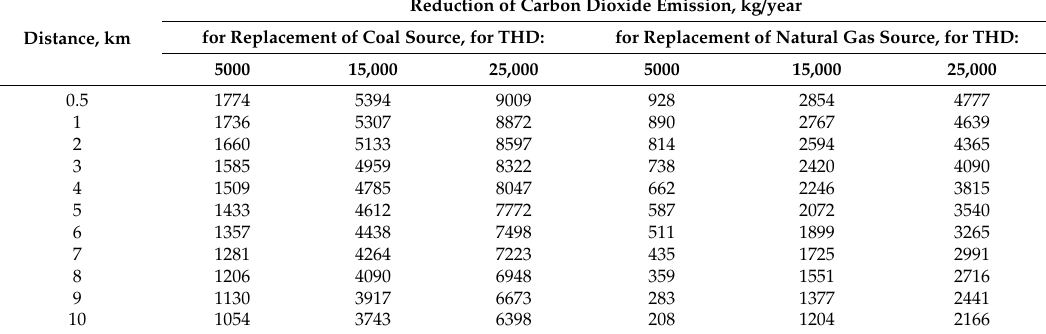
Table 3. Carbon dioxide emission reduction as a function of distance, THD and replacement heat source. Source: own